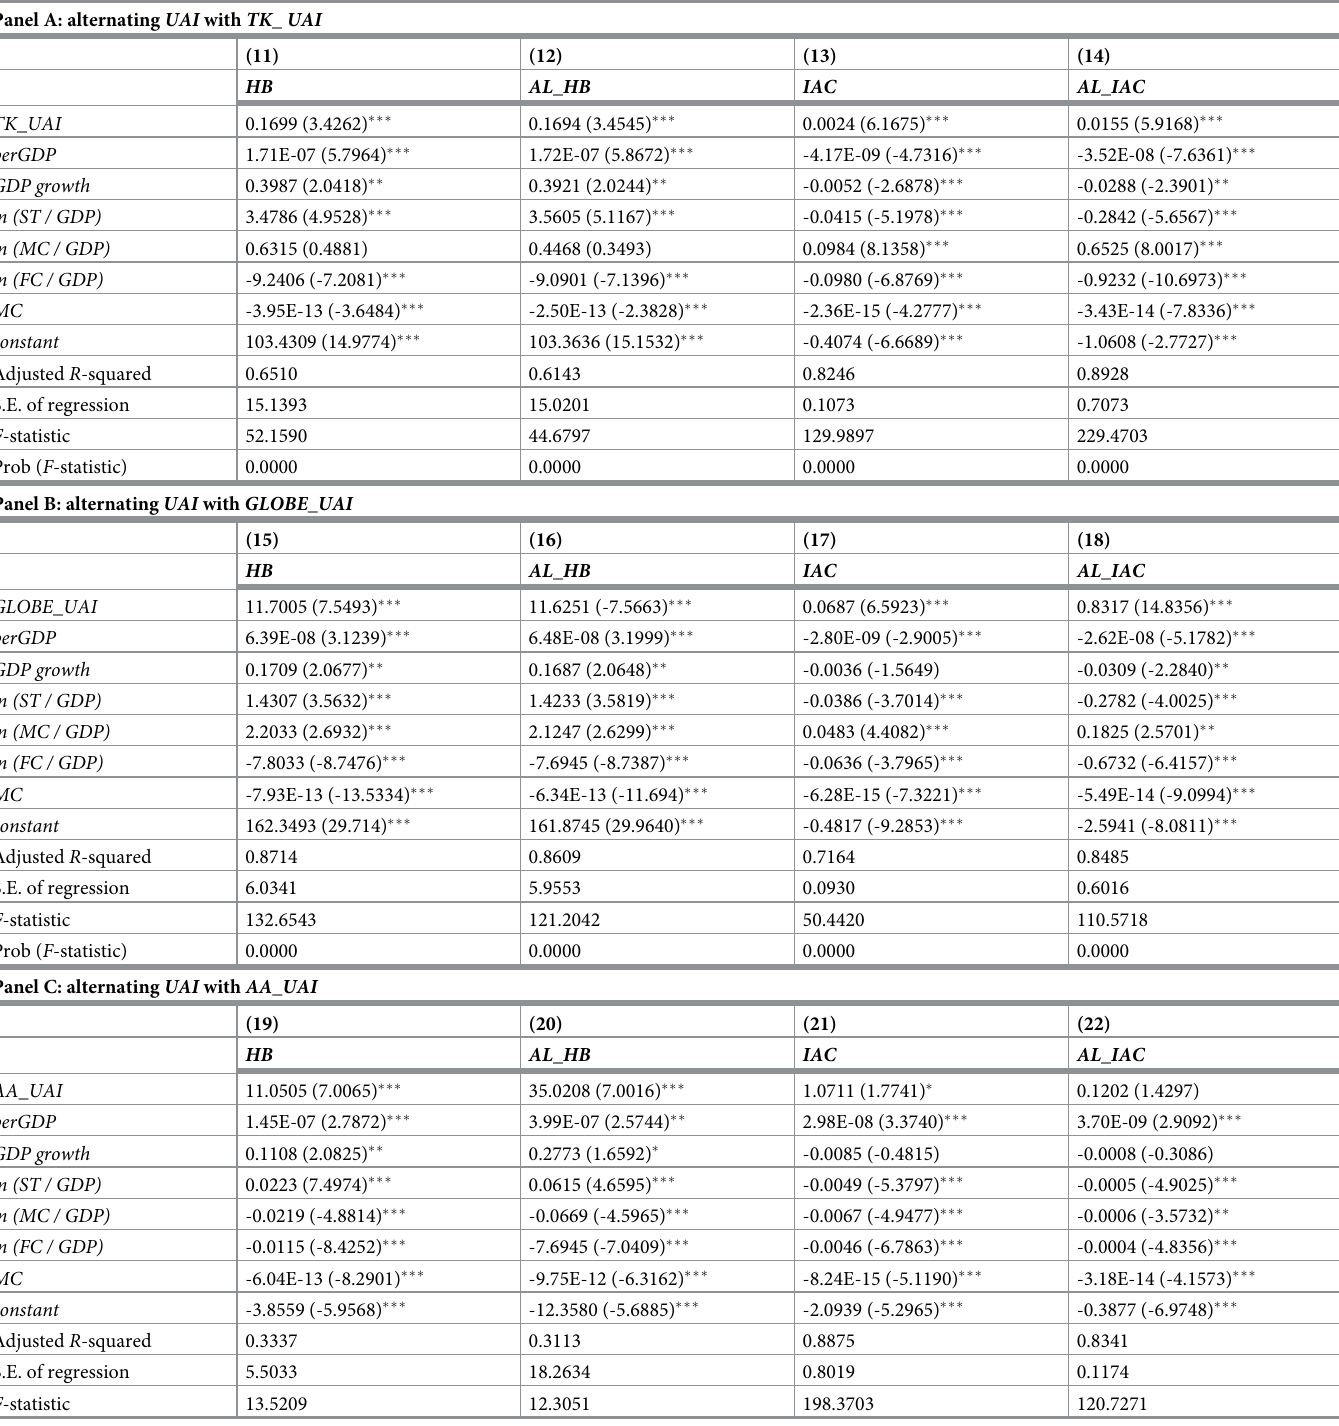
Table 5. The robustness results from the alternating measure of uncertainty